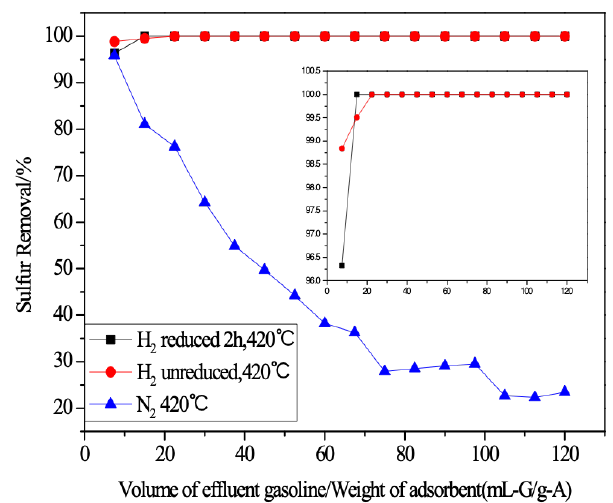
Figure 1. Desulfurization performance of reduced and unreduced adsorbent under different atmospheres.